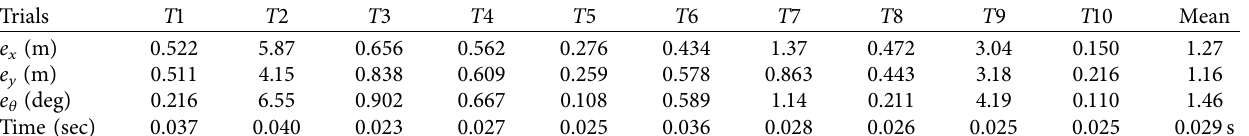
Table 8: The mean of the trials of the EKF (two landmarks and non-Gaussian noise).